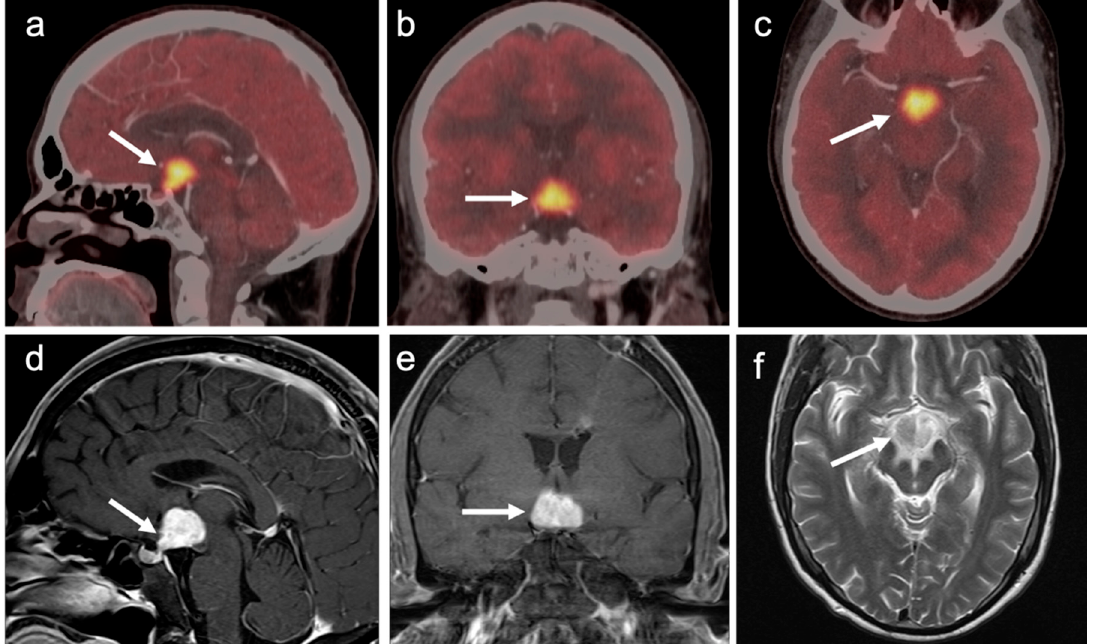
Figure 45. Hypothalamic metastasis from melanoma. ( a – c ) Sagittal, coronal and axial FDG PET-CT images demonstrate intensely hypermetabolic hypothalamic mass (white arrows). ( d , e ) Sagittal and coronal Gd-enhanced T1 MRI and ( f ) axial T2 MRI demonstrate a corresponding enhancing hypothalamic mass, proven at biopsy to be a melanoma metastasis. Although rare, metastases to the hypothalamic–hypophyseal axis do occur and have been described with melanoma [137,138].